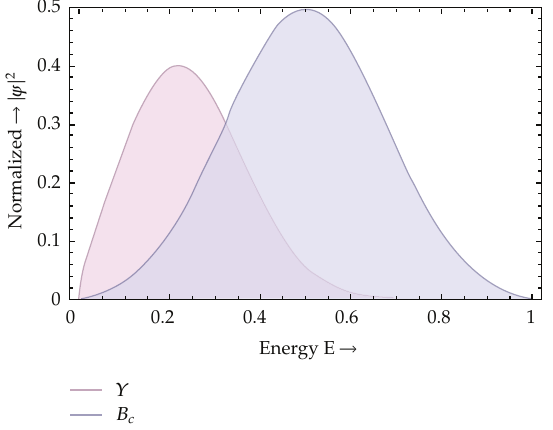
Figure 3: The overlap of wave functions for Υ → 𝐵 𝑐 decays at 𝜔 Υ = = 0.96 1.80 GeV and 𝜔 𝐵 𝑐